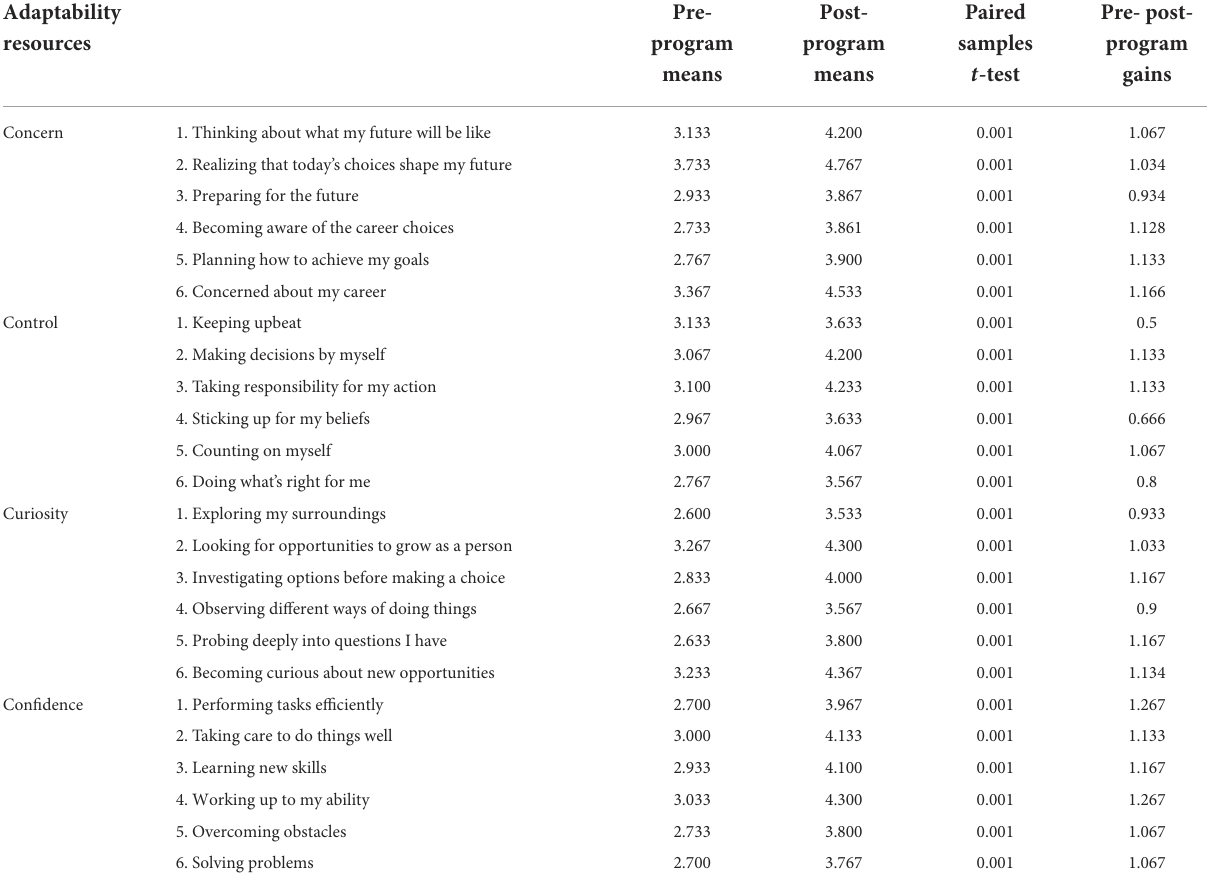
TABLE 5 Pre/post-program mean values for CAAS first-order indicators. Adaptability